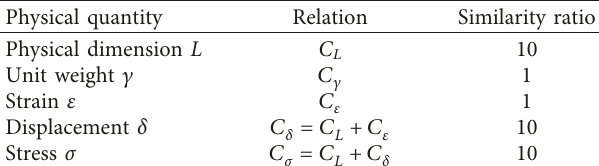
Table 3: Constants’ similarity relation in the model test.